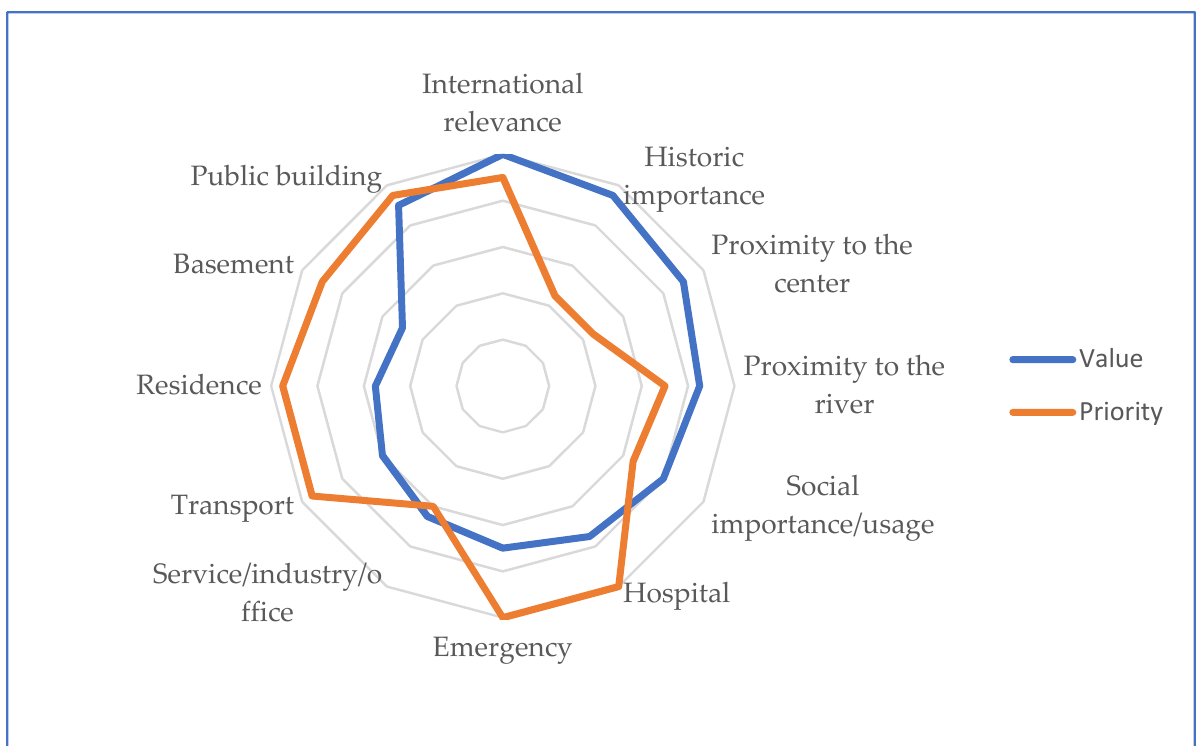
Figure 12. Comparison of the assigned degrees of value and priority for the principal categories of MU.